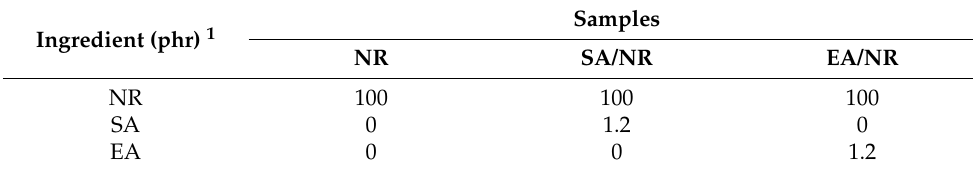
Table 1. The formulas of AO/NR